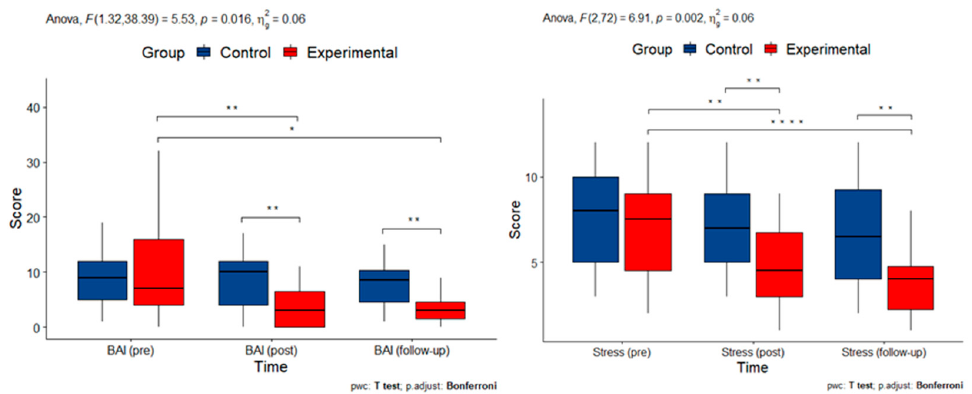
Figure 4. Box plots of measurements of mental health indices with statistically significant interactions (BAI: Beck Anxiety Inventory; Stress: Perceived Stress score; pre: pre-intervention; post: post- intervention). Asterisks denote statistically significant pairwise comparisons.